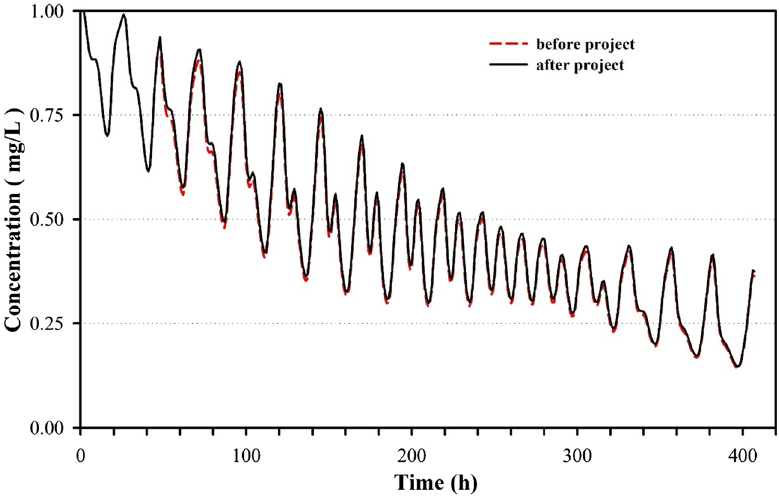
Figure 5. The variations of concentration of conservative substance with time in the water before and after the project. The figure was drawn with SigmaPlot Version 10.0.